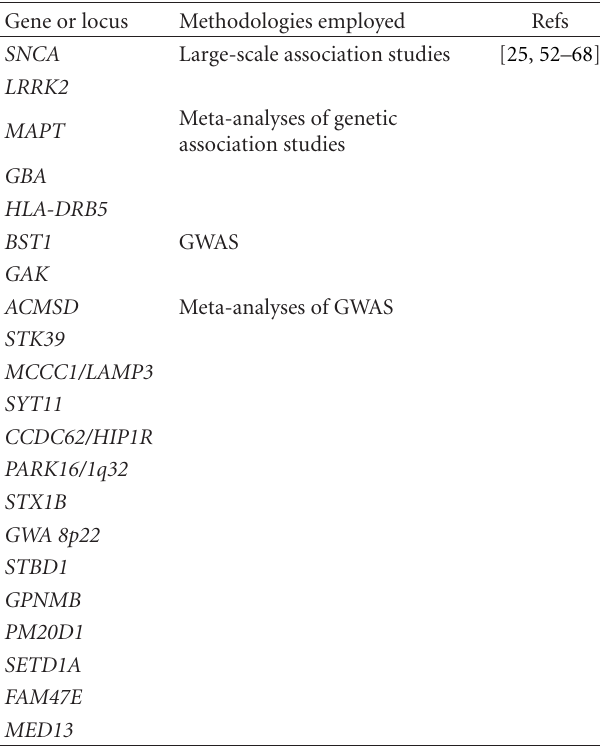
Table 3: Genes or loci associated with idiopathic